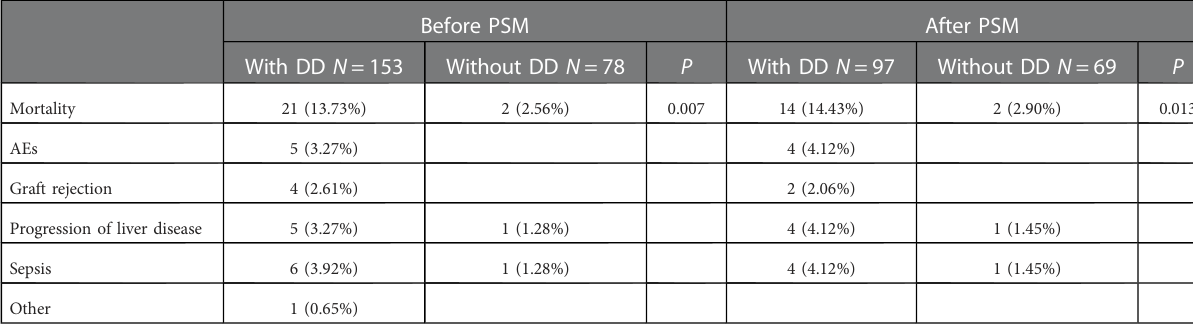
TABLE 6 Categories of 1-year mortality